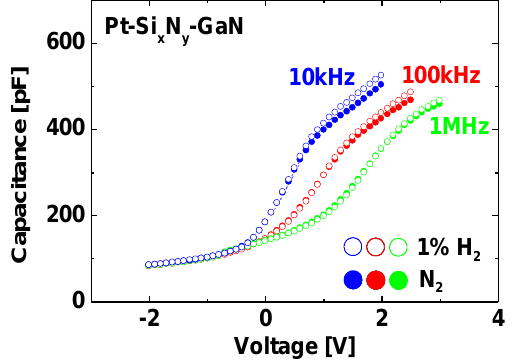
Figure 9. Room-temperature C-V characteristics of the MIS Pt–GaN diodes with a Si dielectric at 10 kHz, 100 kHz and 1 MHz in a N to 1% H in N 2 2